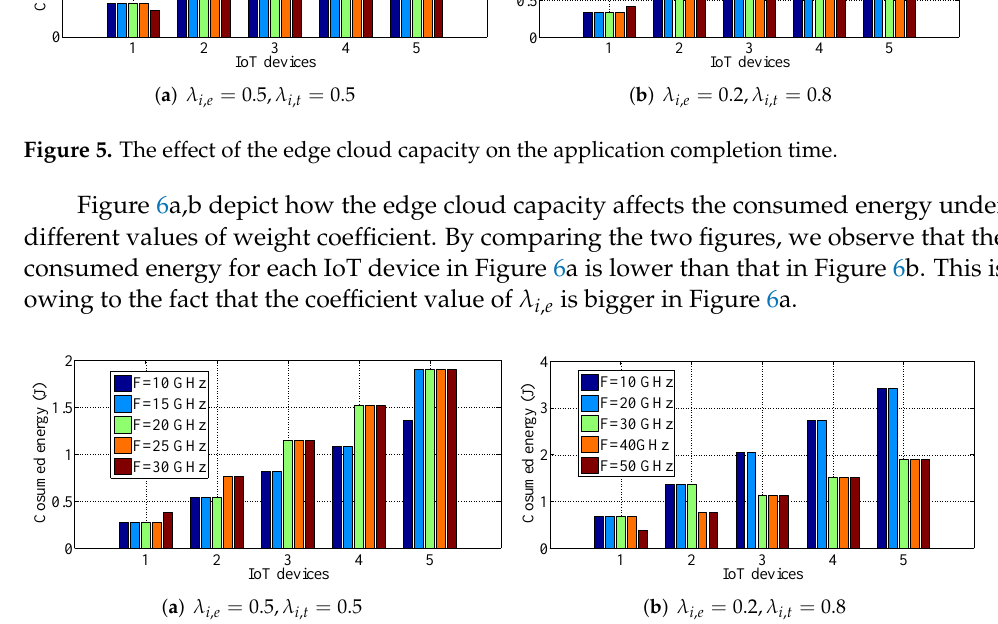
Figure 6. The effect of the edge cloud capacity on the consumed